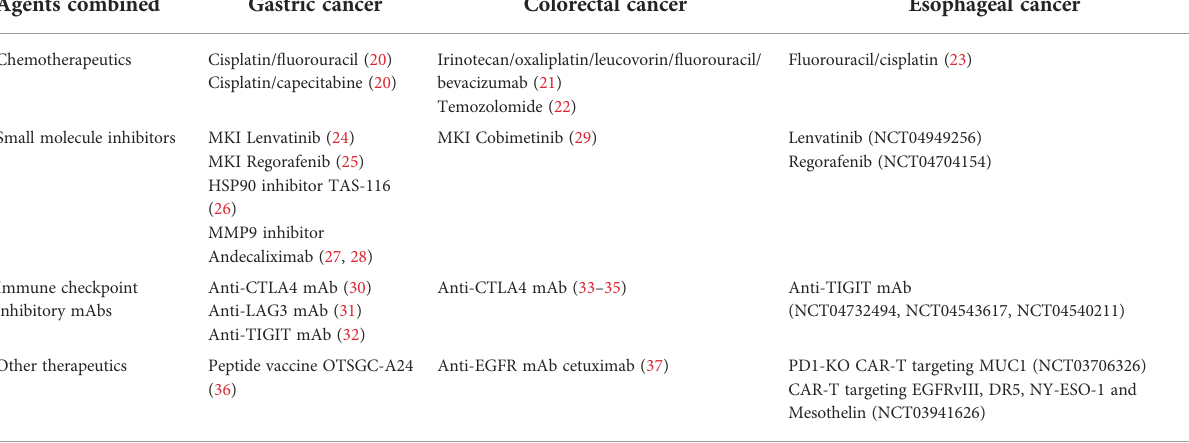
TABLE 1 Agents combined with anti-PD1/PDL1 mAbs in ongoing clinical trials (References). Agents